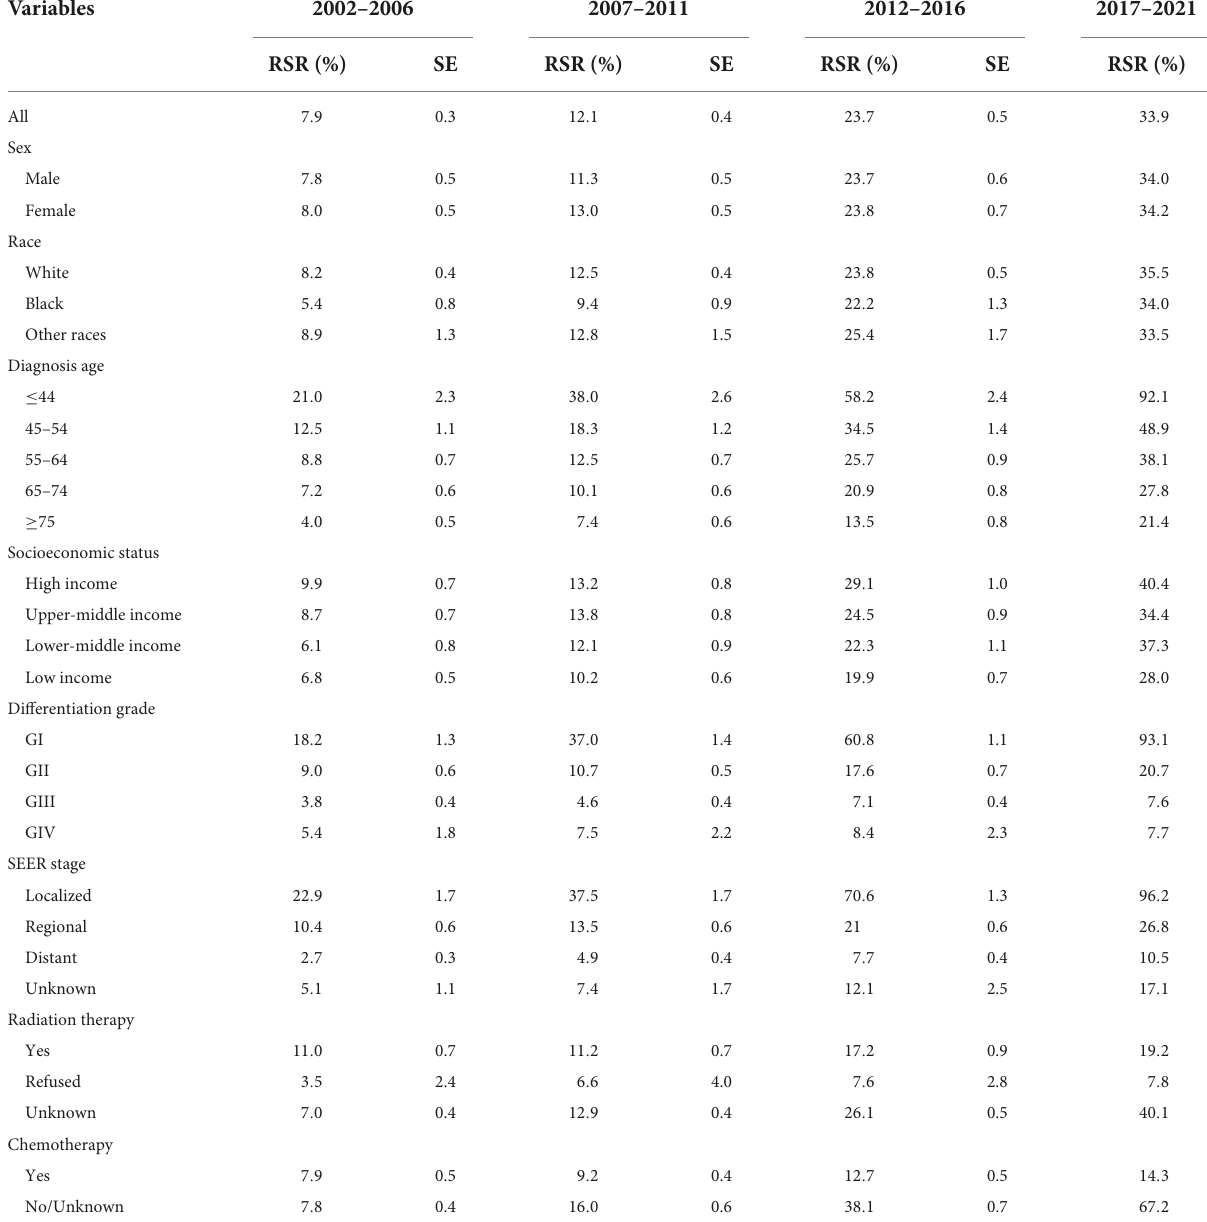
TABLE 3 The survival rate of patients with pancreatic cancer (PC) by all variables from 2002 to 2016 and the survival rate prediction of different variables from 2017 to 2021.